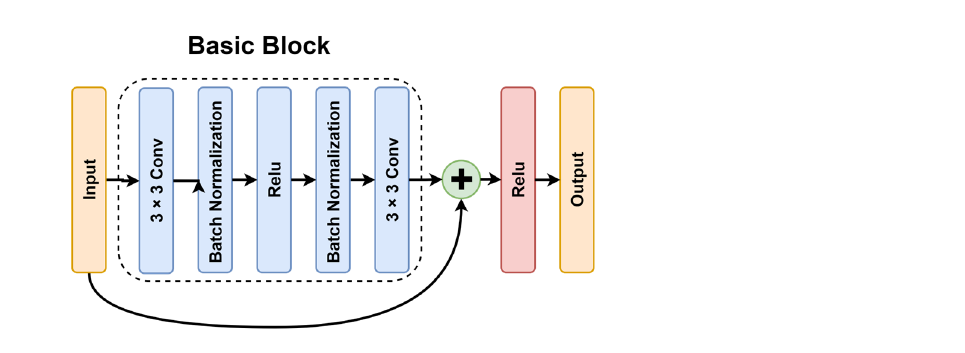
Figure 7. Basic Block. Table 1. Lists the inputs and outputs of the network